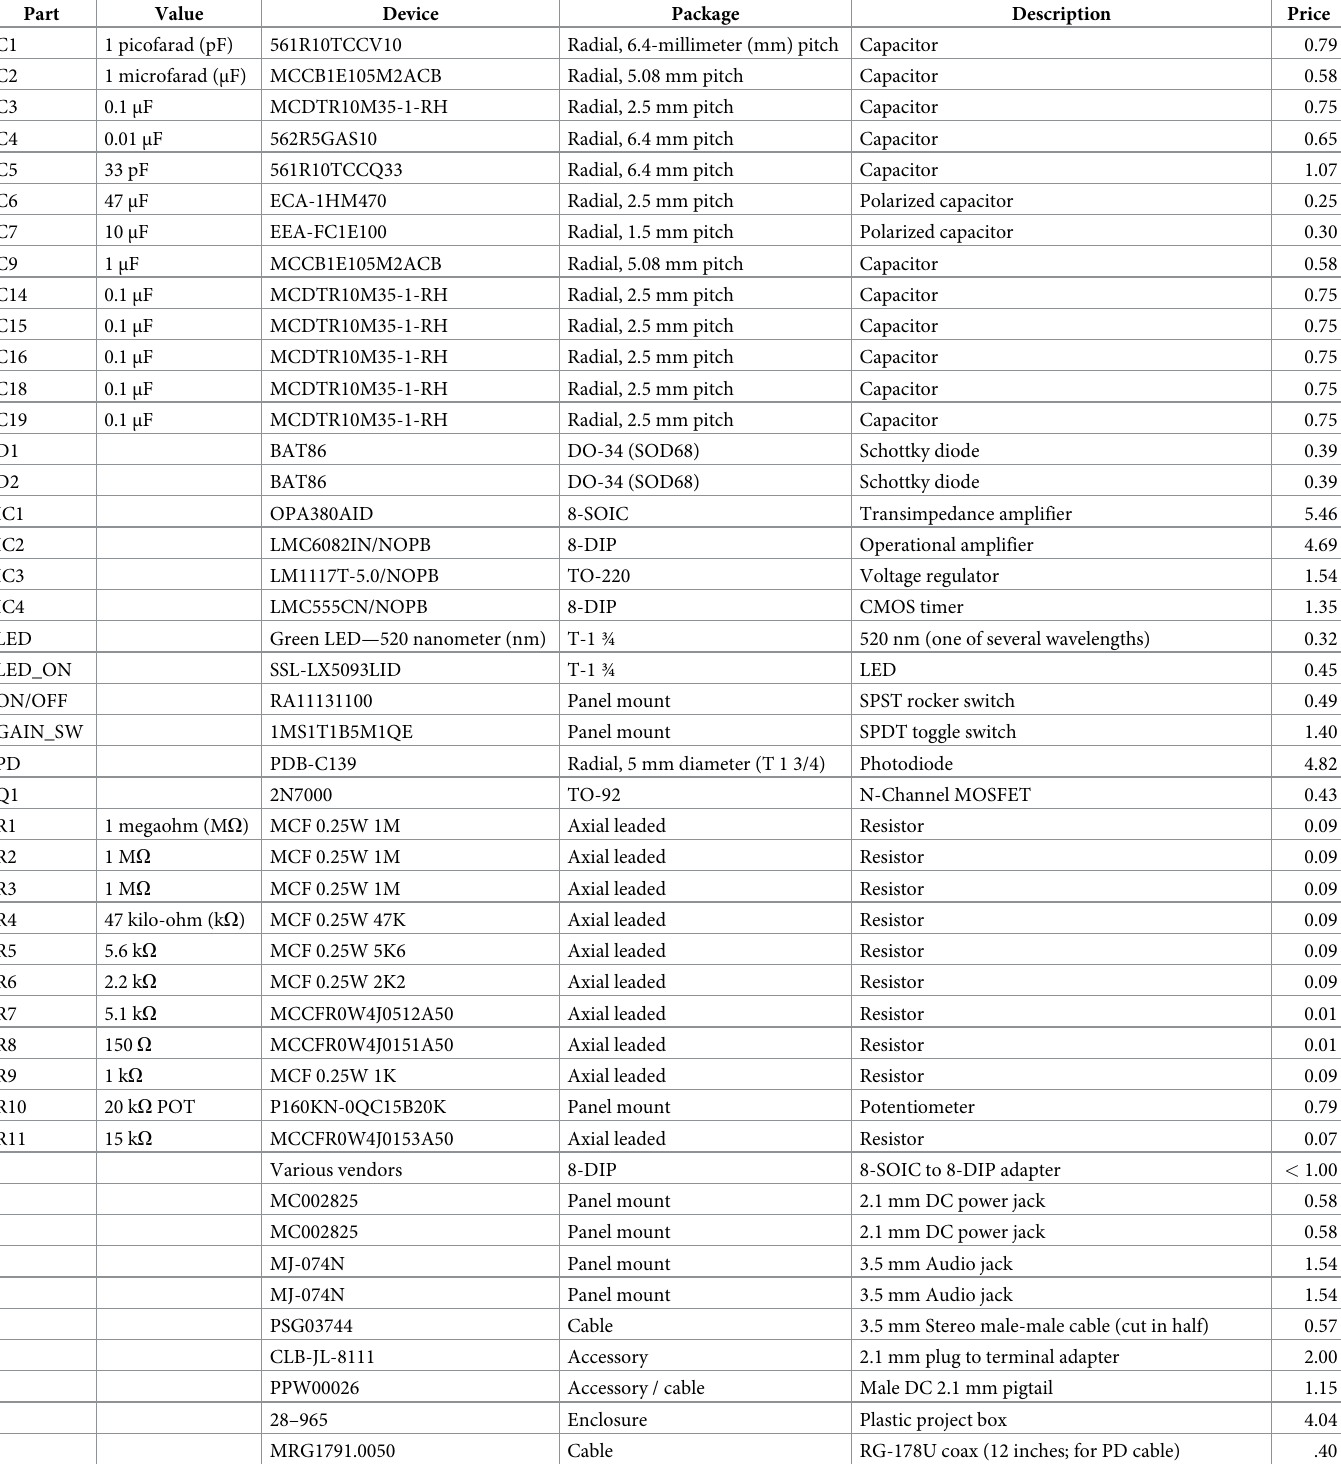
Table 1. A list of the parts and associated prices in current (2019) United States Dollars (USD) for 1 light emitting diode (LED) spectrophotometer. These prices are from Newark (www.newark.com), Digi-Key Electronics (www.digikey.com), and Amazon.com, Inc. (www.amazon.com).